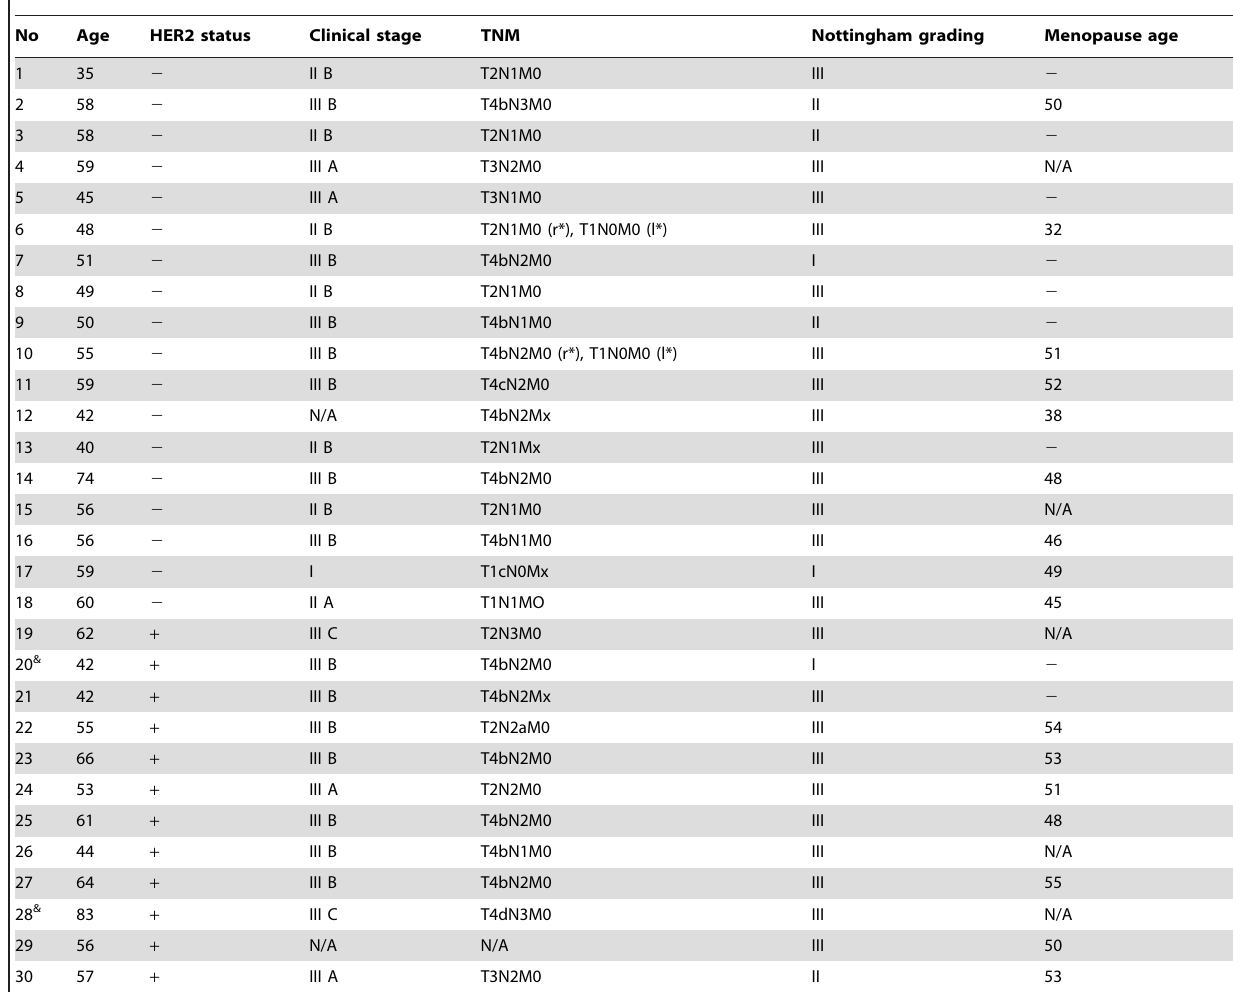
Table 1. Clinicopathological features of